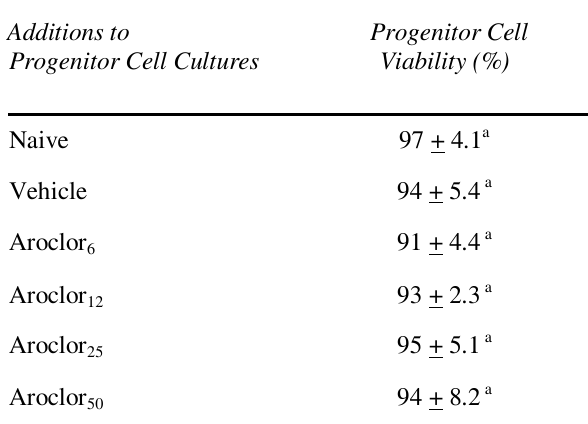
Table 1: Effect of Aroclor on Progenitor Cell Viabiliy: Isolated PC (5 X 10 6 cells/mL) was incubated with or vehicle for 24 hrs. After this Aroclor (6, 12, 25 or 50 µM) incubation, PC was washed and viability was assessed = PCB mixture, by eosin Y uptake analysis. Aroclor (X) Aroclor, where (X) is the concentration of Aroclor; Values represent mean + S.E.M.; a, indicates values that are significant